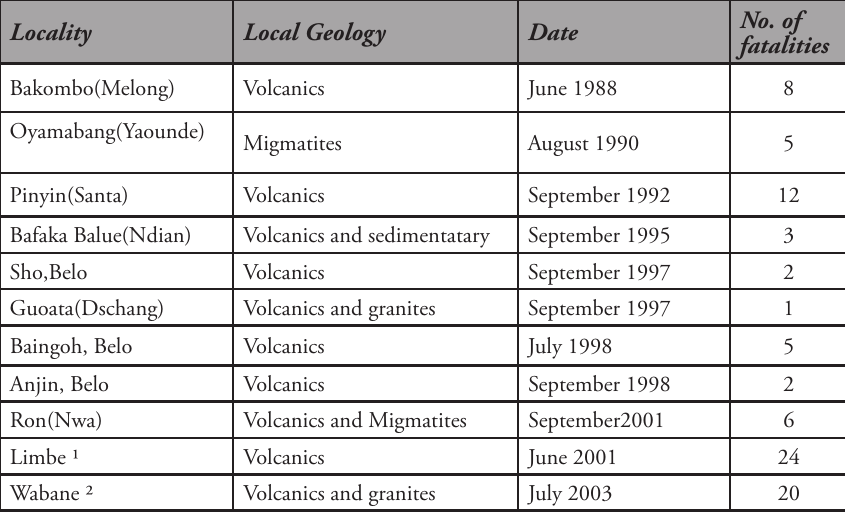
Table 1: Reported landslide casualties in Cameroon since 1988